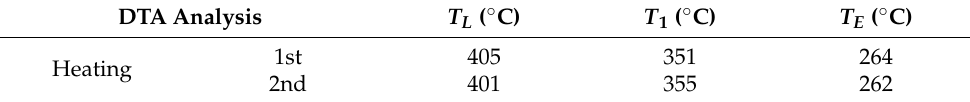
Table 3. Significant temperatures of phase transformations determined by TG/DTA analysis.